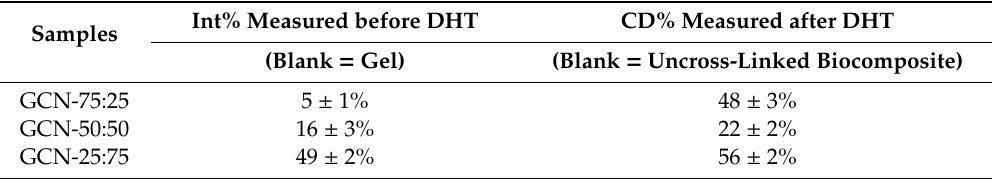
Table 2. Interaction degree for the polymer chains (Int%) and the cross-linking degree (CD%) after the DHT treatment for the Gel–CNF biocomposites measured by TNBS (2,4,6-trinitrobenzenesulfonic acid) assay.